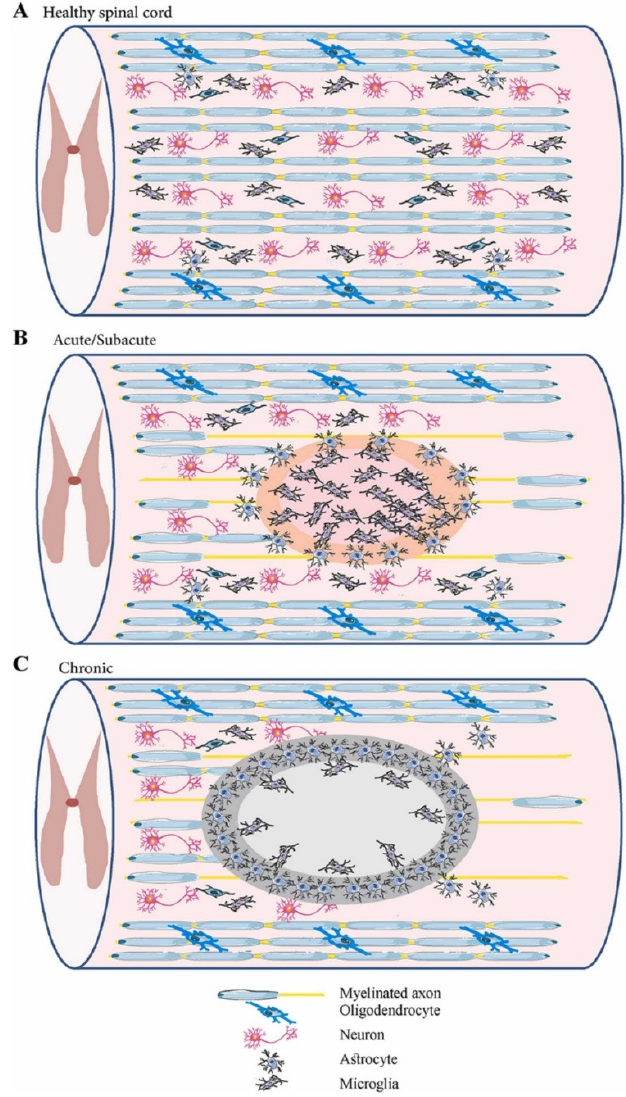
Figure 1. Schematic representation of the spinal cord in different phases: ( A ) healthy spinal cord; ( B ) acute/subacute injury phase (marked by cell necrosis originating from the spinal cord injury (SCI) and activation of inflammatory processes); ( C ) chronic phase (marked by cyst cavity formation and lesion expansion). Reprinted from an open-access source [21].